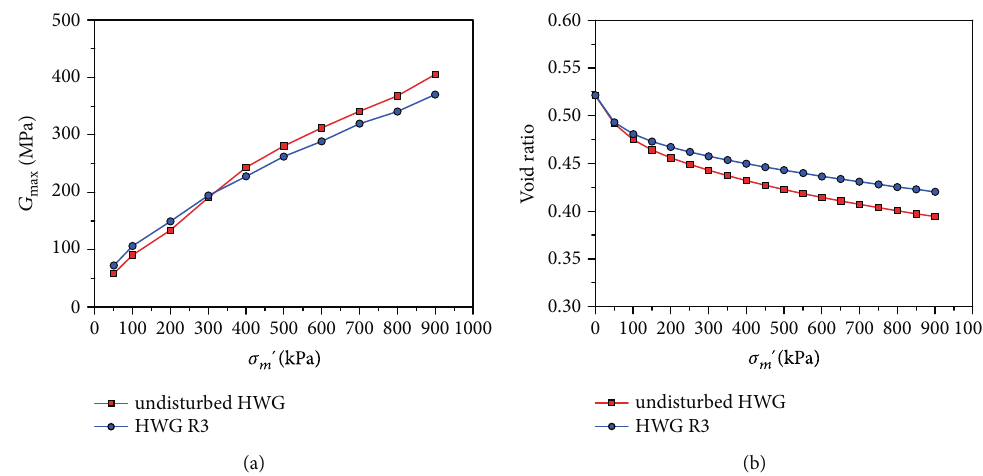
− σ ′ curves for the undisturbed HWG sample and the remolded HWG R3 sample; (b) compression curves of the Figure 7: (a) G max undisturbed HWG sample and the remolded HWG R3 sample for